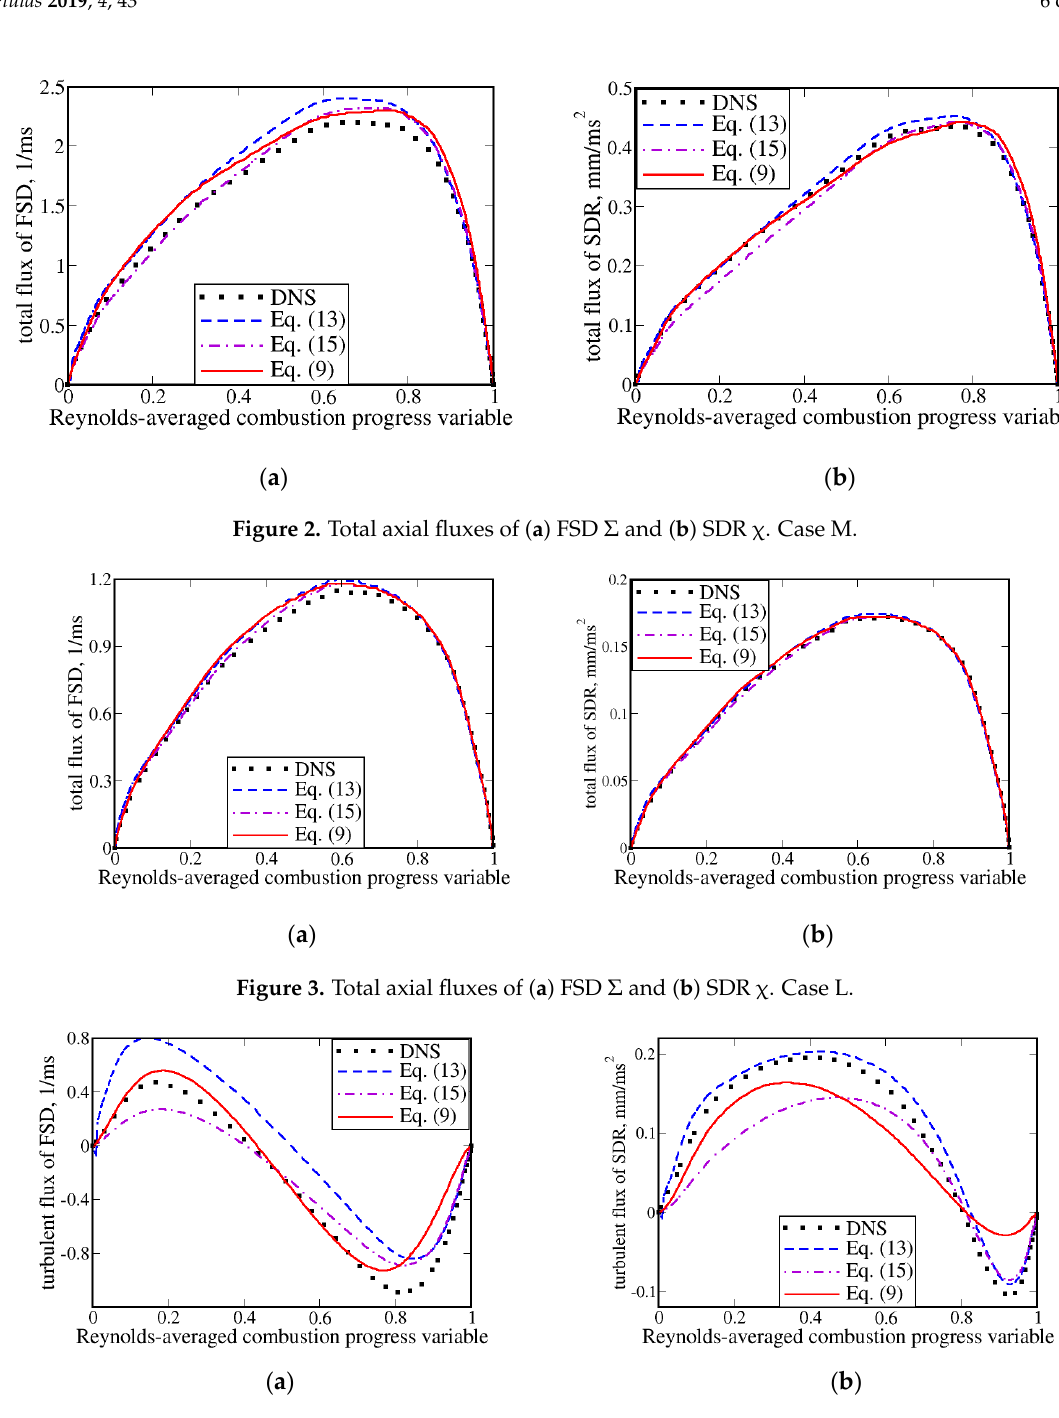
Figure 1. Total axial fluxes of ( a ) flame surface density (FSD) Σ and ( b ) scalar dissipation rate (SDR) χ . Case H.